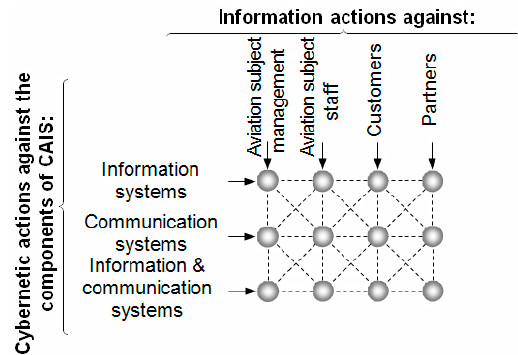
Fig. 4. Interaction matrix for the given example